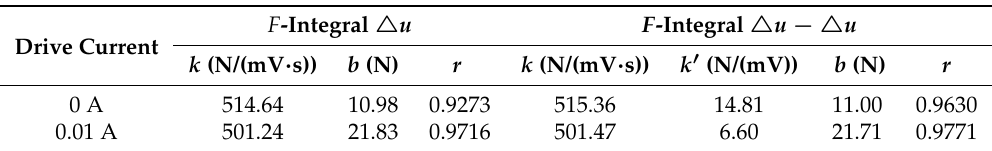
Table 1. Parameters of regression